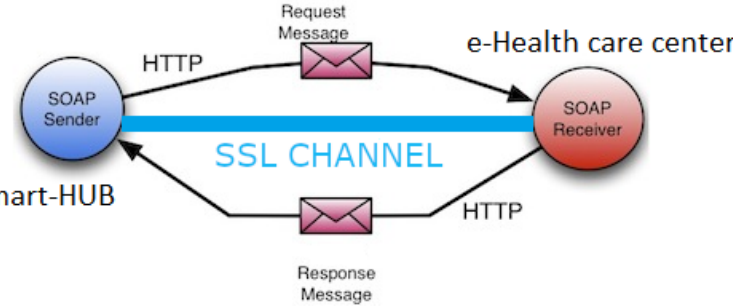
Figure 5. General integration scheme between smart-hub and e-Health care center, based on